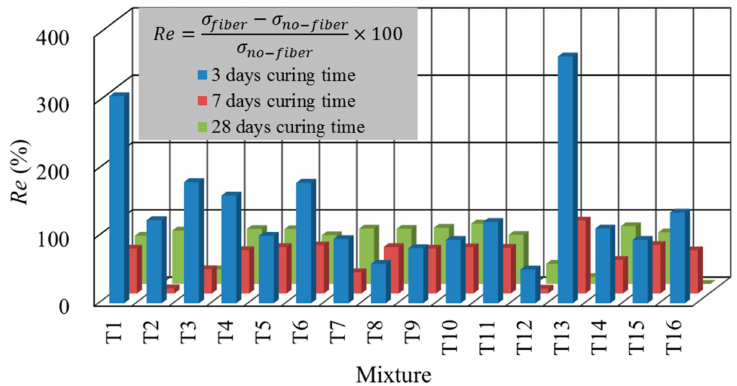
Figure 4. The UCS increases the ratio of the fiber-reinforced CPB.